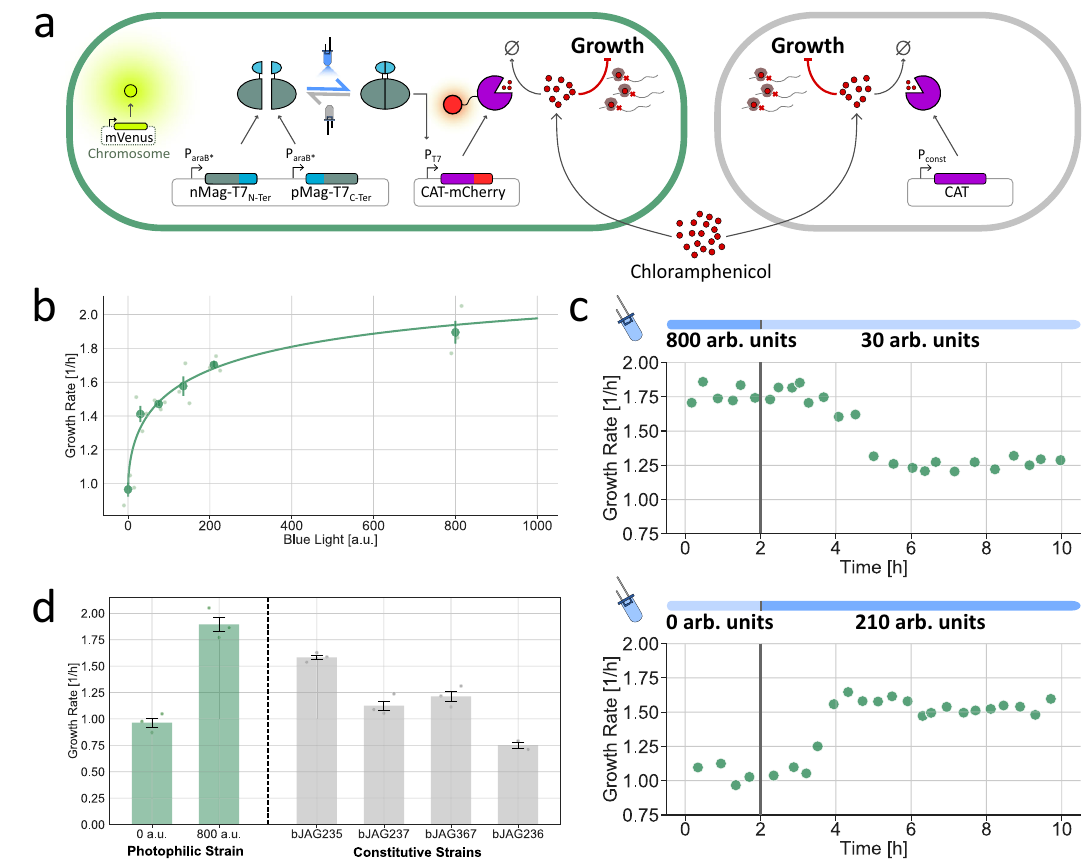
Fig. 2 | Optogenetic control of cellular growth rate. a Schematic of the genetic circuits used in this study. Control over the growth rate is achieved by growing E. coli in the presence of a fi xed concentration of chloramphenicol and titrating the expressionofchloramphenicolacetyltransferase(CAT),anenzymethatinactivates the antibiotic. The photophilic strain (top) carries a split T7 polymerase fused to light-inducible heterodimerization domains and the CAT gene, placed under con- trol of a T7-promoter. Blue-light illumination leads to reconstitution of active T7- polymerase units and production of CAT, which in turn results in faster growth. In the constitutive strain (bottom), the CAT gene is expressed from a constitutive promoter, so that the growth rate is independent of light. b Dose-response of the growth rate of the photophilic strain to blue-light intensity in the presence of sub- lethal concentrations of chloramphenicol (10.5 μ M). Data are presented as mean values+/ − SEM, with the median steady-state growth rate of individual biological replicates shown as data points with different transparency ( n =3 biologically